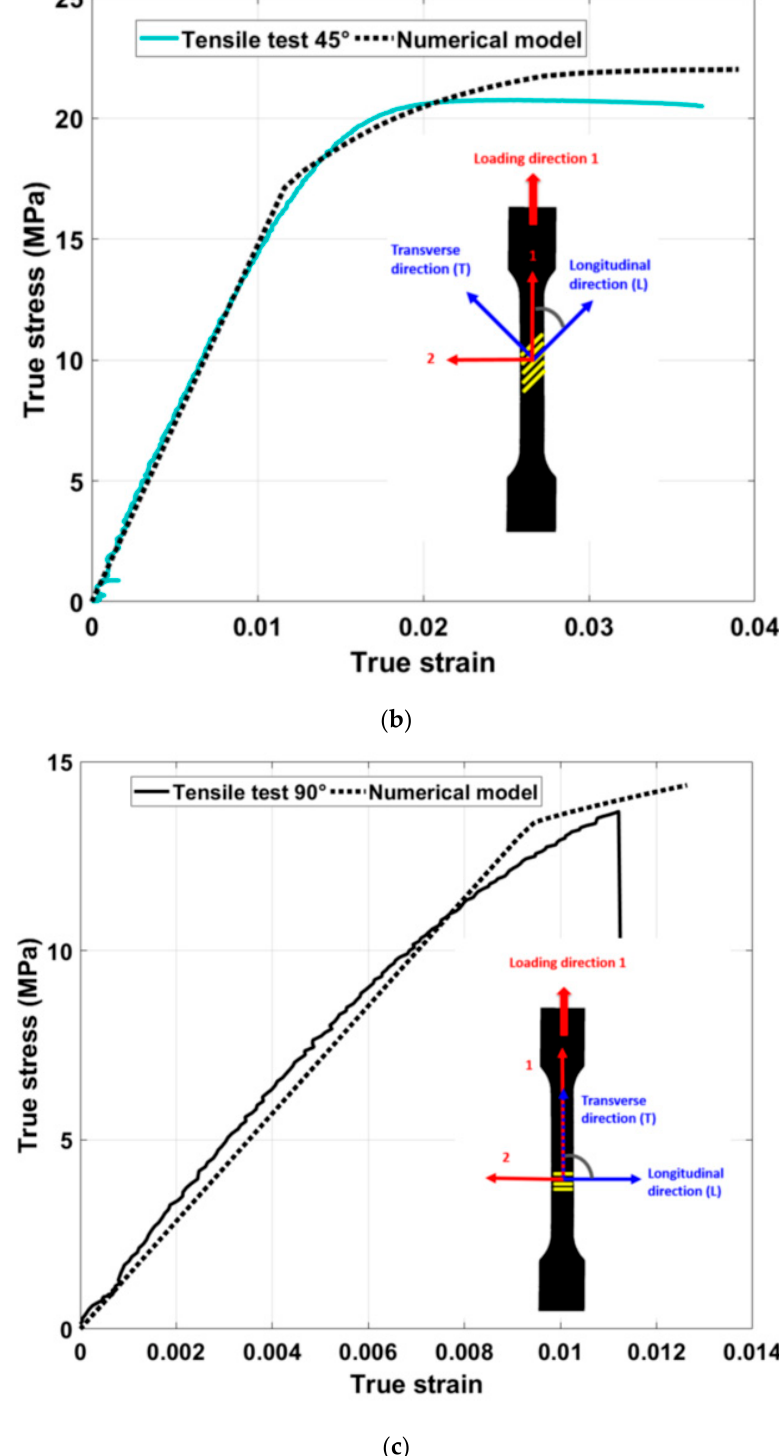
Figure 7. Model response of the tensile test specimens compared to a representative experimental curve. ( a ): 0° raster orientation and ( b ): 45° raster orientation and ( c ): 90° raster orientation.